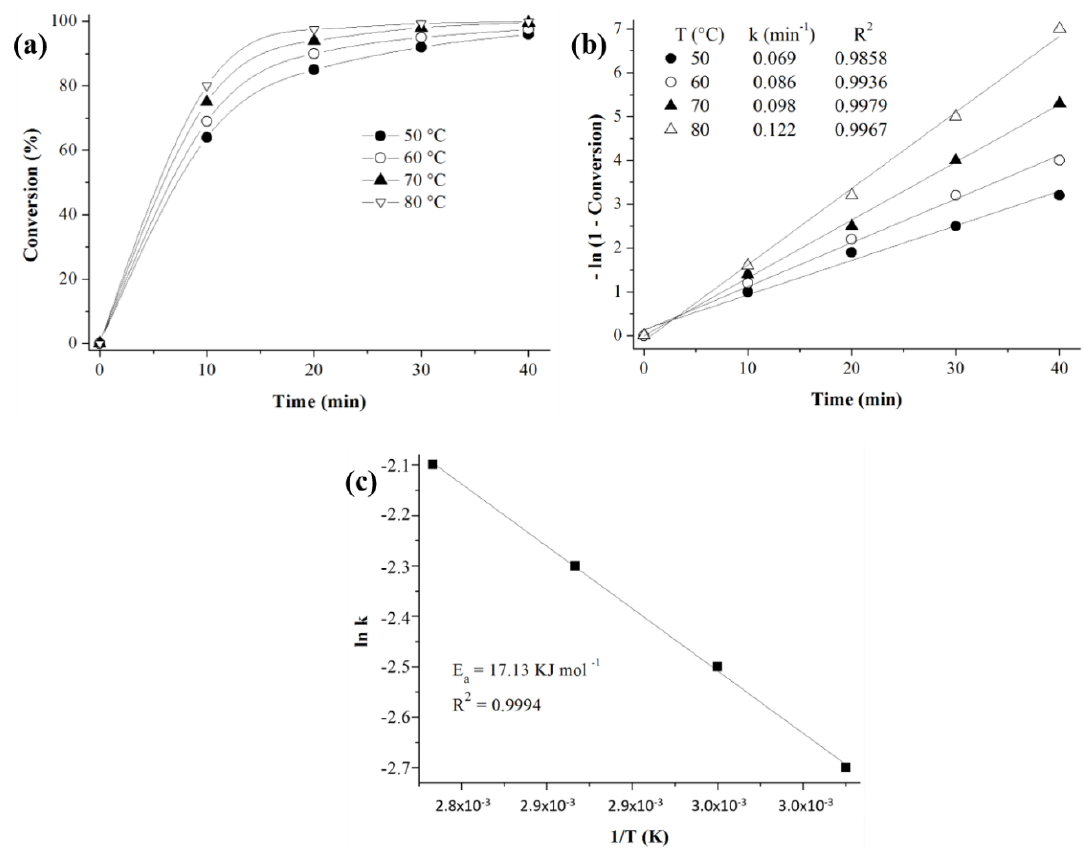
Figure 10. ( a ) Kinetic studies of the conversion of eugenol over the catalysts; ( b ) graphs of − ln (1–conversion) versus time at different temperatures for calculations of velocity constants and reaction order analysis; ( c ) Arrhenius graph for calculating the activation energy for eugenol esterification reaction at different temperatures on the catalyst.